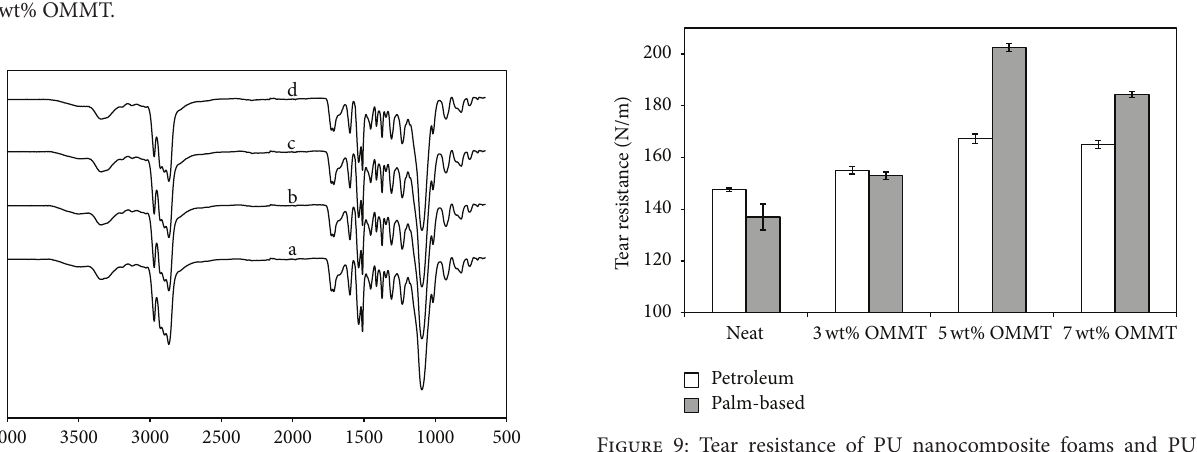
Figure 9: Tear resistance of PU nanocomposite foams and PU bionanocomposite foams with different amounts of